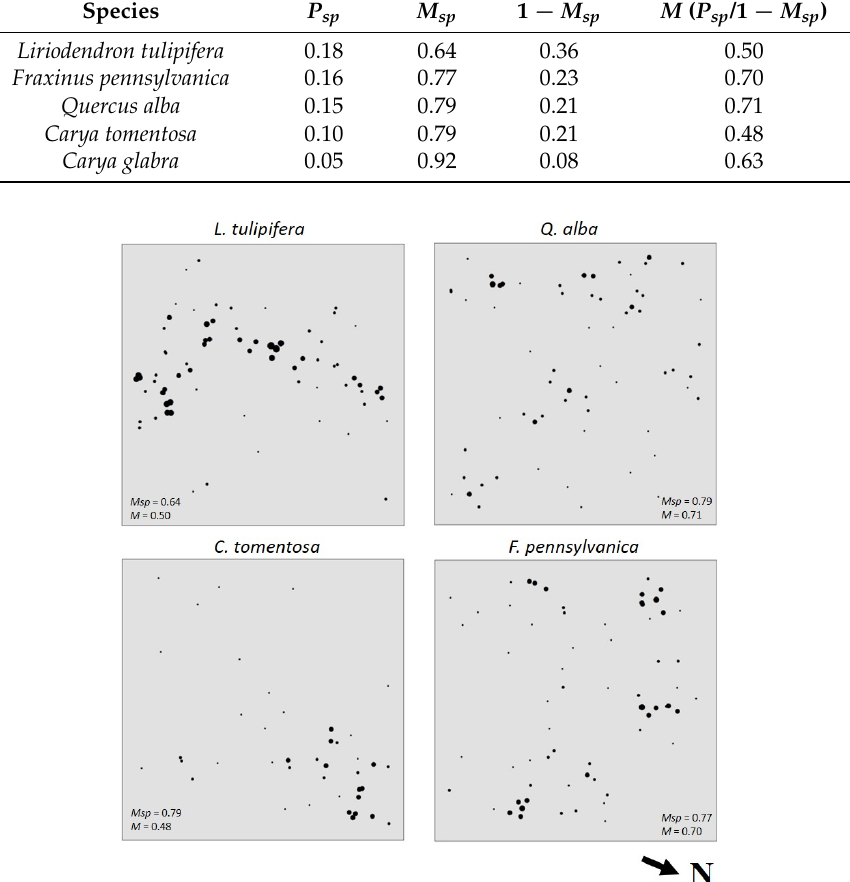
Figure 5. Stem maps showing the position of trees (>5 cm dbh) across a 1 ha (100 m × 100 m) plot for the four most abundant species in a multi-cohort forest on the Oakmulgee Ranger District of the Talladega National Forest. Dot size reflects the M i value for each stem with larger dots reflecting lower M i values. Note stems within 5 m of the plot boundary are not shown.